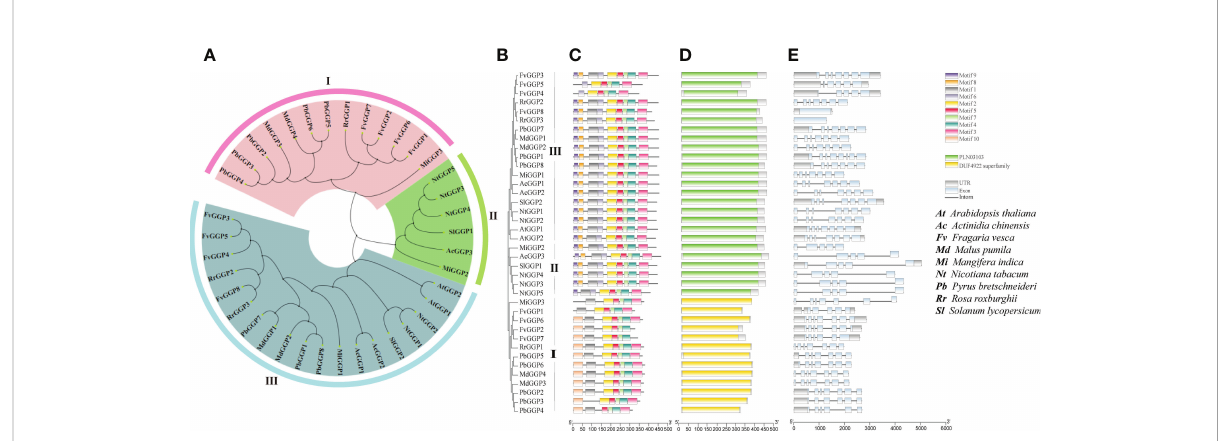
FIGURE 4 Phylogenetic relationships, gene structures and conserved protein motifs of plant GGP genes. (A, B) The un-rooted NJ phylogenetic tree of plant GGP genes. (C) Conserved motif compositions and distribution of the plant GGP genes. (D) Domain analysis of plant GGP genes. (E) Exon – intron structure of plant GGP genes. Phylogenetic analysis of the GGP genes in Arabidopsis thaliana , Solanum lycopersicum , Fragaria vesca , Pyrus bretschneideri , Mangifera indica , Actinidia chinensis , Nicotiana tabacum , Malus pumila and Rosa roxburghii . The unrooted tree was generated by MEGA7 using the conserved amino acid sequences of the 3 kinds RrGGP proteins. GGP protein groups were distinguished by different colors. The conserved motifs were detected using MEME software and represented by colored boxes. The length of GGP proteins can be estimated using the scale at the bottom, and the conserved motifs were shown in Table